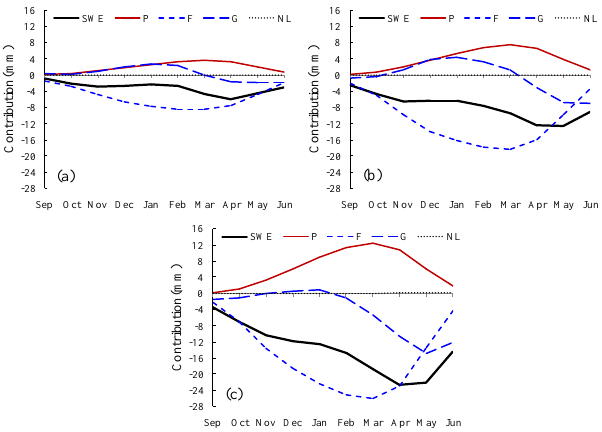
Figure 9. Mean changes in SWE decomposed using Eq. (4) to show the contribution of changes in precipitation ( (cid:49)P) , the fraction of solid precipitation ( (cid:49)F) , the fraction of accumulated snowfall that remains on the ground ( (cid:49)G) , and nonlinear terms (NL) during the period of 2016–2035 (a) , 2046–2065 (b) , and 2080–2099 (c) for RCP8.5, relative to the 1986–2005 reference